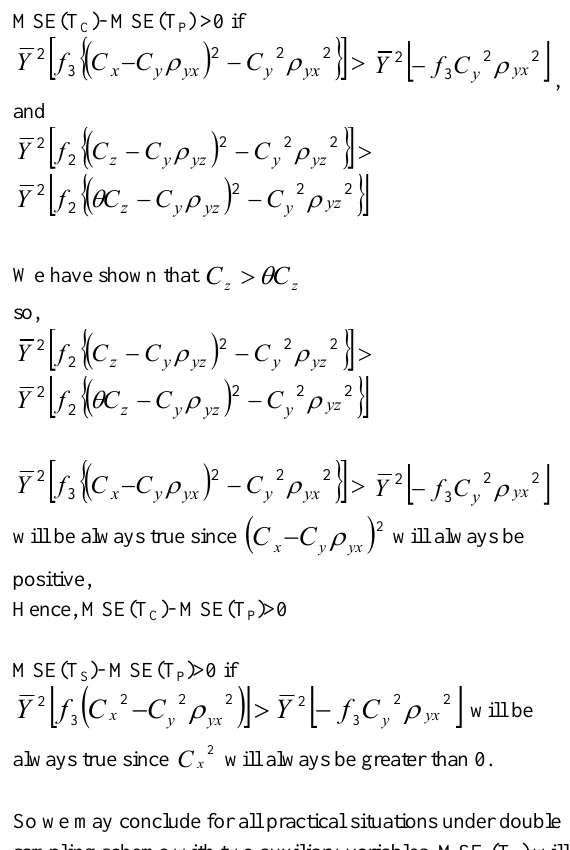
x: average tree height in the sample plot in meter (m) z: average crown diameter in the sample plot in meter